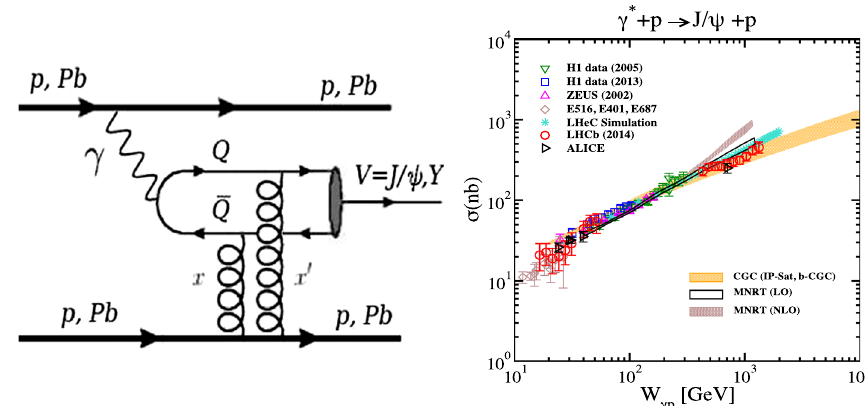
Fig. 16.9 Left: diagram representing exclusive quarkonia photoproduction in UPCs. Right: dependence of the exclusive J / ψ photoproduction cross section on the photon-hadron c.m. energy in the regions covered by HERA, LHC and future FCC studies